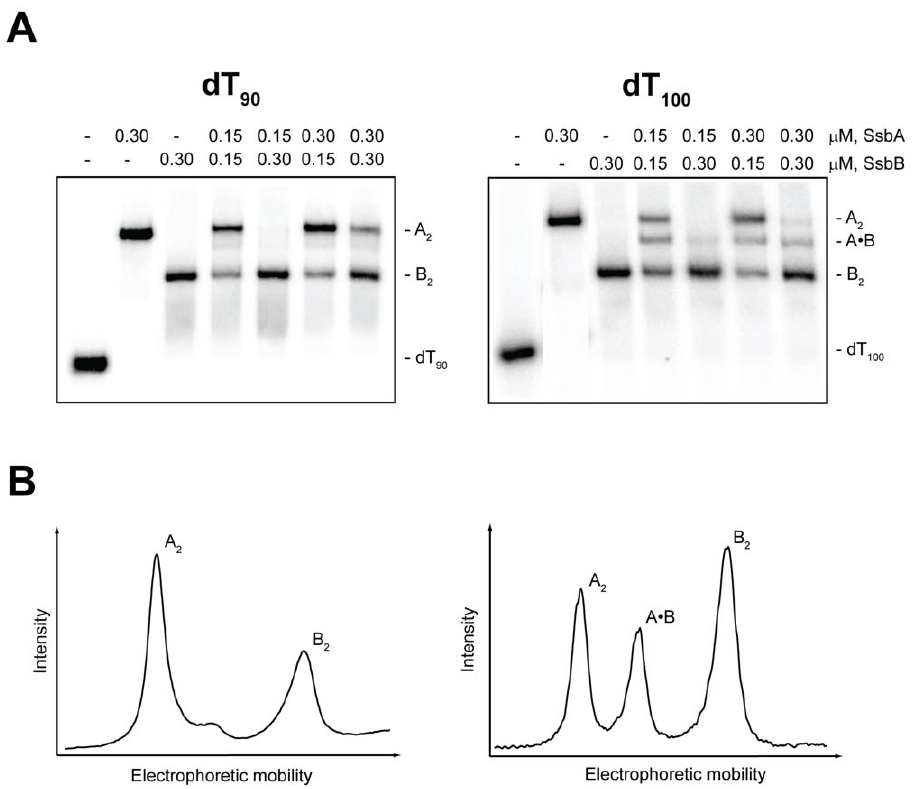
Figure 6. Binding of SsbA and SsbB proteins to dT 90 and dT 100 in the absence of Mg 2 + . The reaction solutions contained 25 mM Tris acetate (pH 7.5), 5 m M dT 90 ( left ) or dT 100 ( right ) (total nucleotide concentration), and the indicated concentrations of SsbA and SsbB protein (tetramer concentrations). A, The reactions were analyzed by polyacrylamide gel electrophoresis using a gel running buffer consisting of Tris acetate (pH 7.5). The bands corresponding to the unbound dT n oligomers, and the A 2 , B 2 , and A ? B complexes, were visualized by phosphorimaging. B, The lanes for the reactions that contained 0.15 m M SsbA, 0.15 m M SsbB, and either dT 90 ( left ) or dT 100 ( right ) were scanned to show the relative intensities of the bands for the indicated